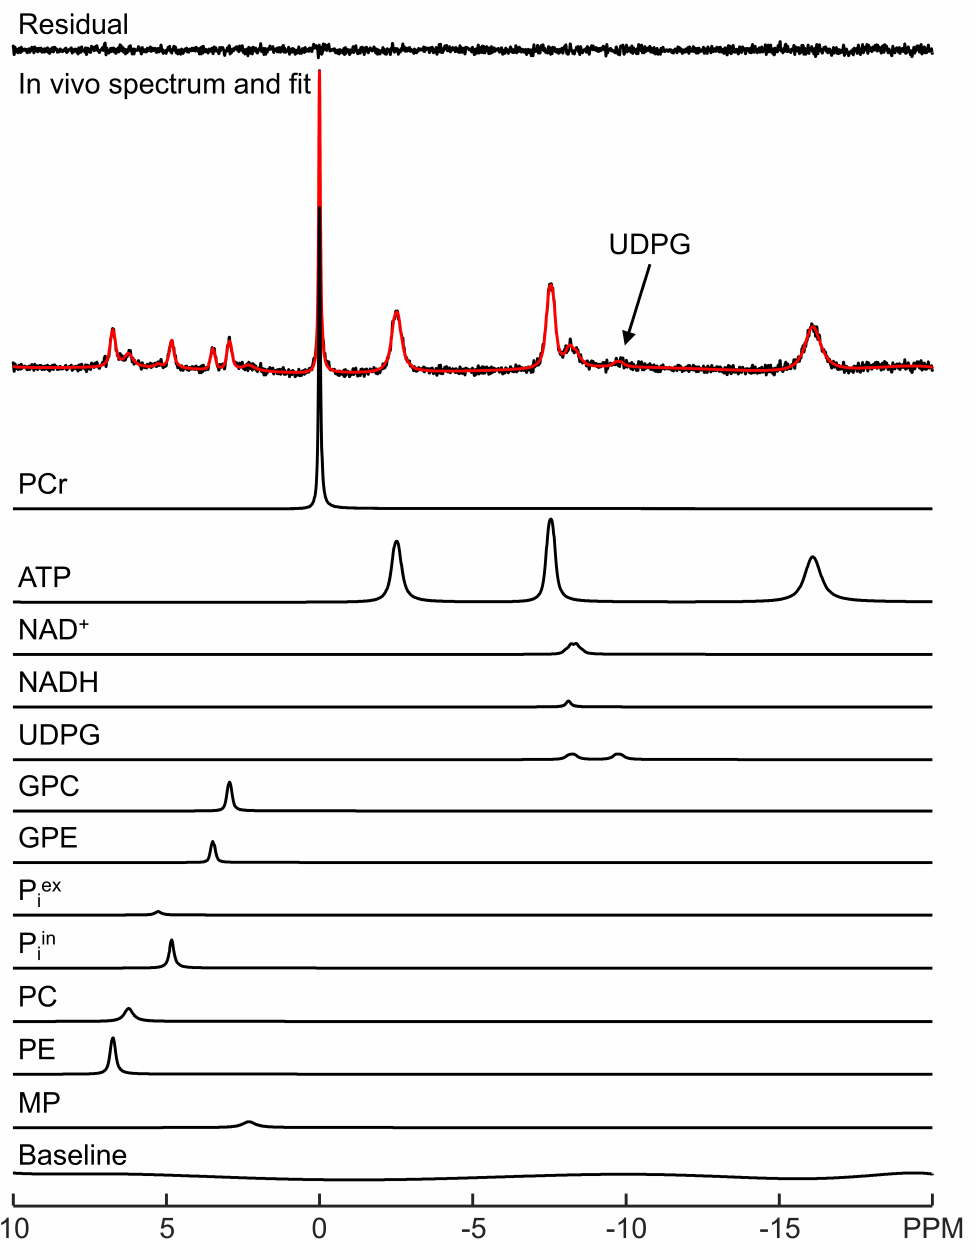
Figure 2. LCM fitting of a representative in vivo 31 P MRS spectrum acquired from human brain at 7 Tesla. The fit (red) and fit residual covering − 20 to 10 ppm are shown, along with fitted individual metabolites and the background spectral